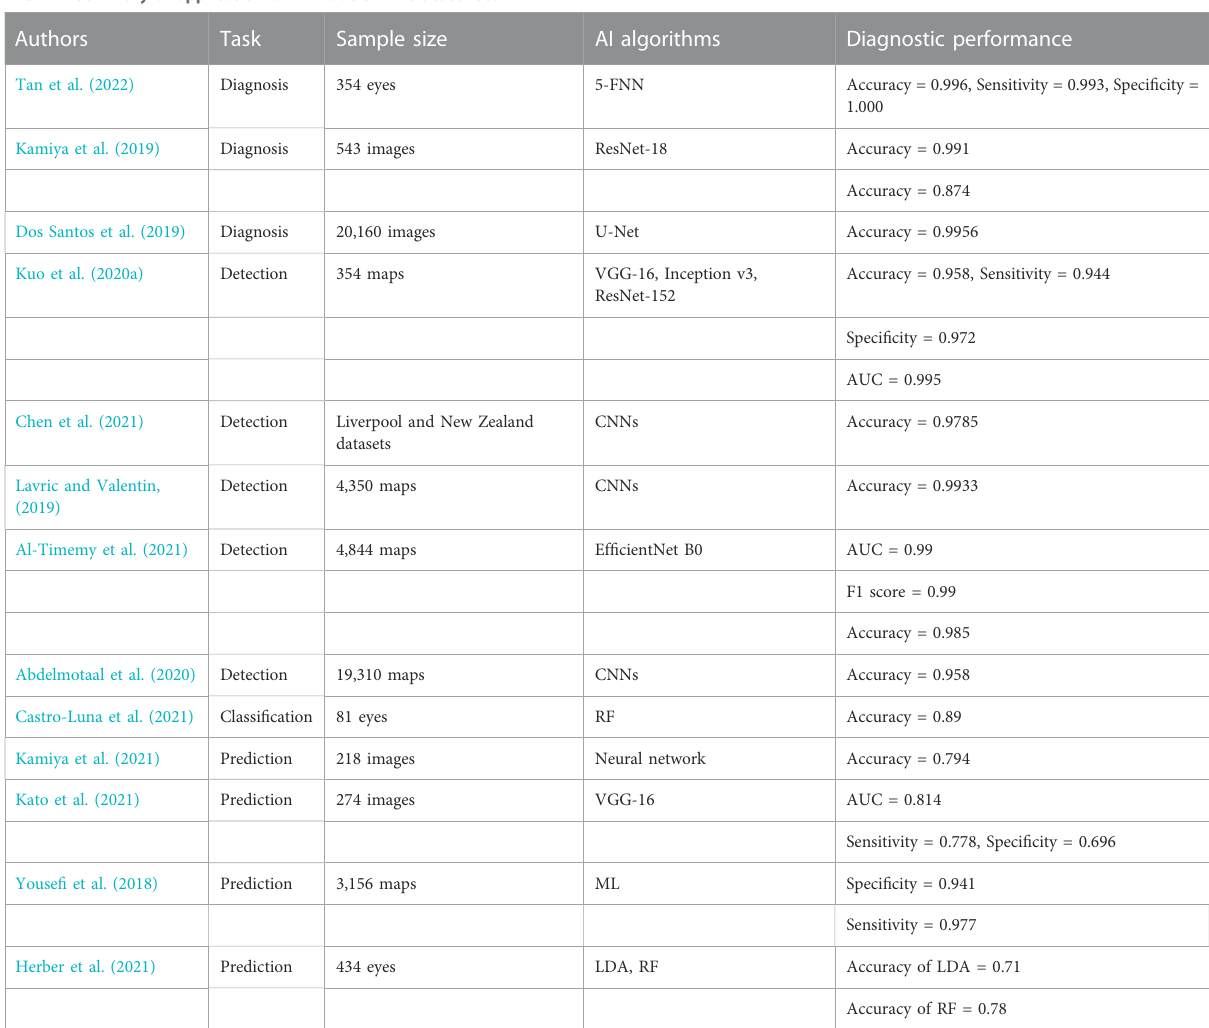
TABLE 2 Summary of application of AI models in